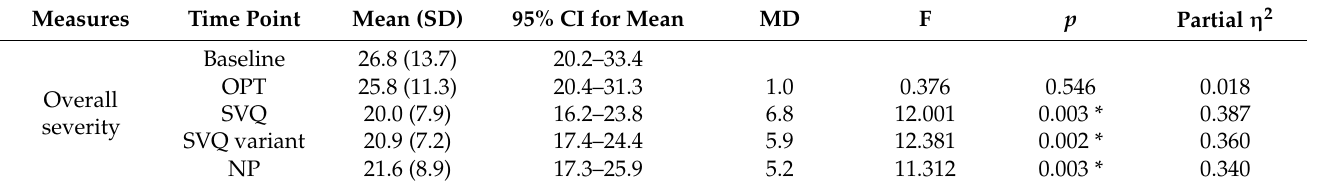
Table 6. Auditory–perceptual outcomes after four stages of Sob Voice Therapy. Partial η 2 = 0.01, 0.1, and 0.25 indicate small, medium, and large effects, respectively. Abbreviation: MD, mean difference; (*), significance at p < 0.05.